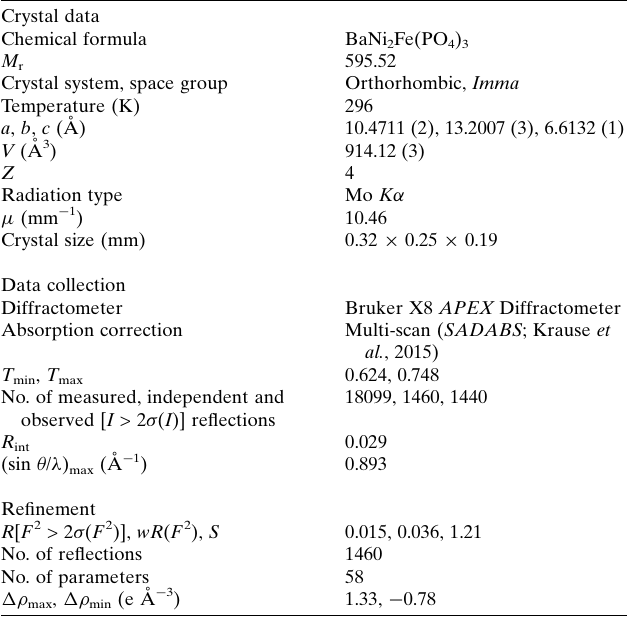
Table 3 Experimental details. Crystal data Chemical